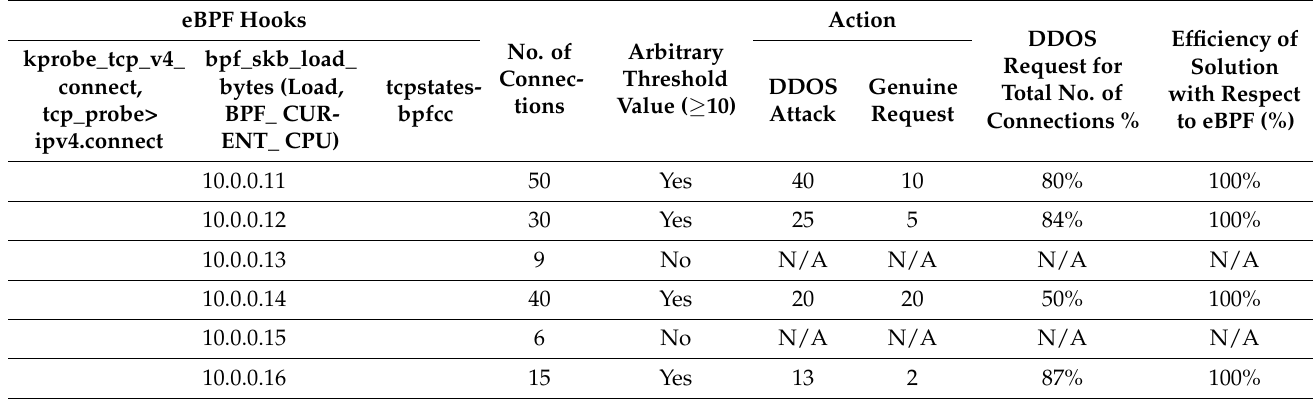
Table 2. Experimental Results.